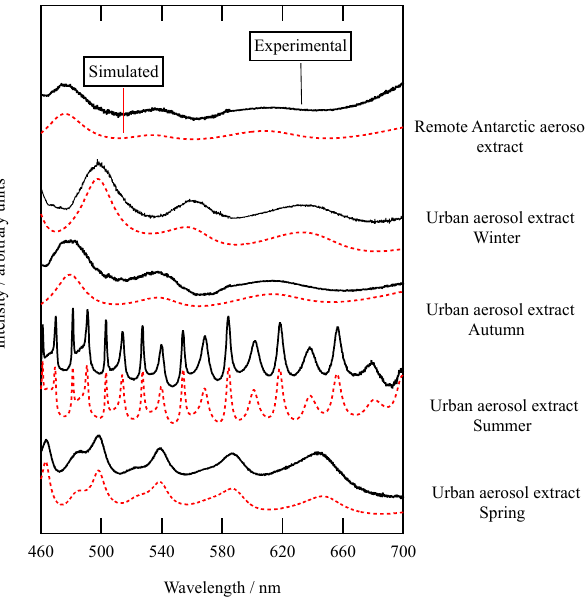
Figure 1. The typical Mie spectra as a function of wavelength ob- tained for the urban atmospheric aerosol extracts (collected over the four seasons) and the remote Antarctic atmospheric aerosol extract. From the Mie spectra, the refractive index and radius of the trapped droplet could be determined. Simulated and measured Mie spectra are